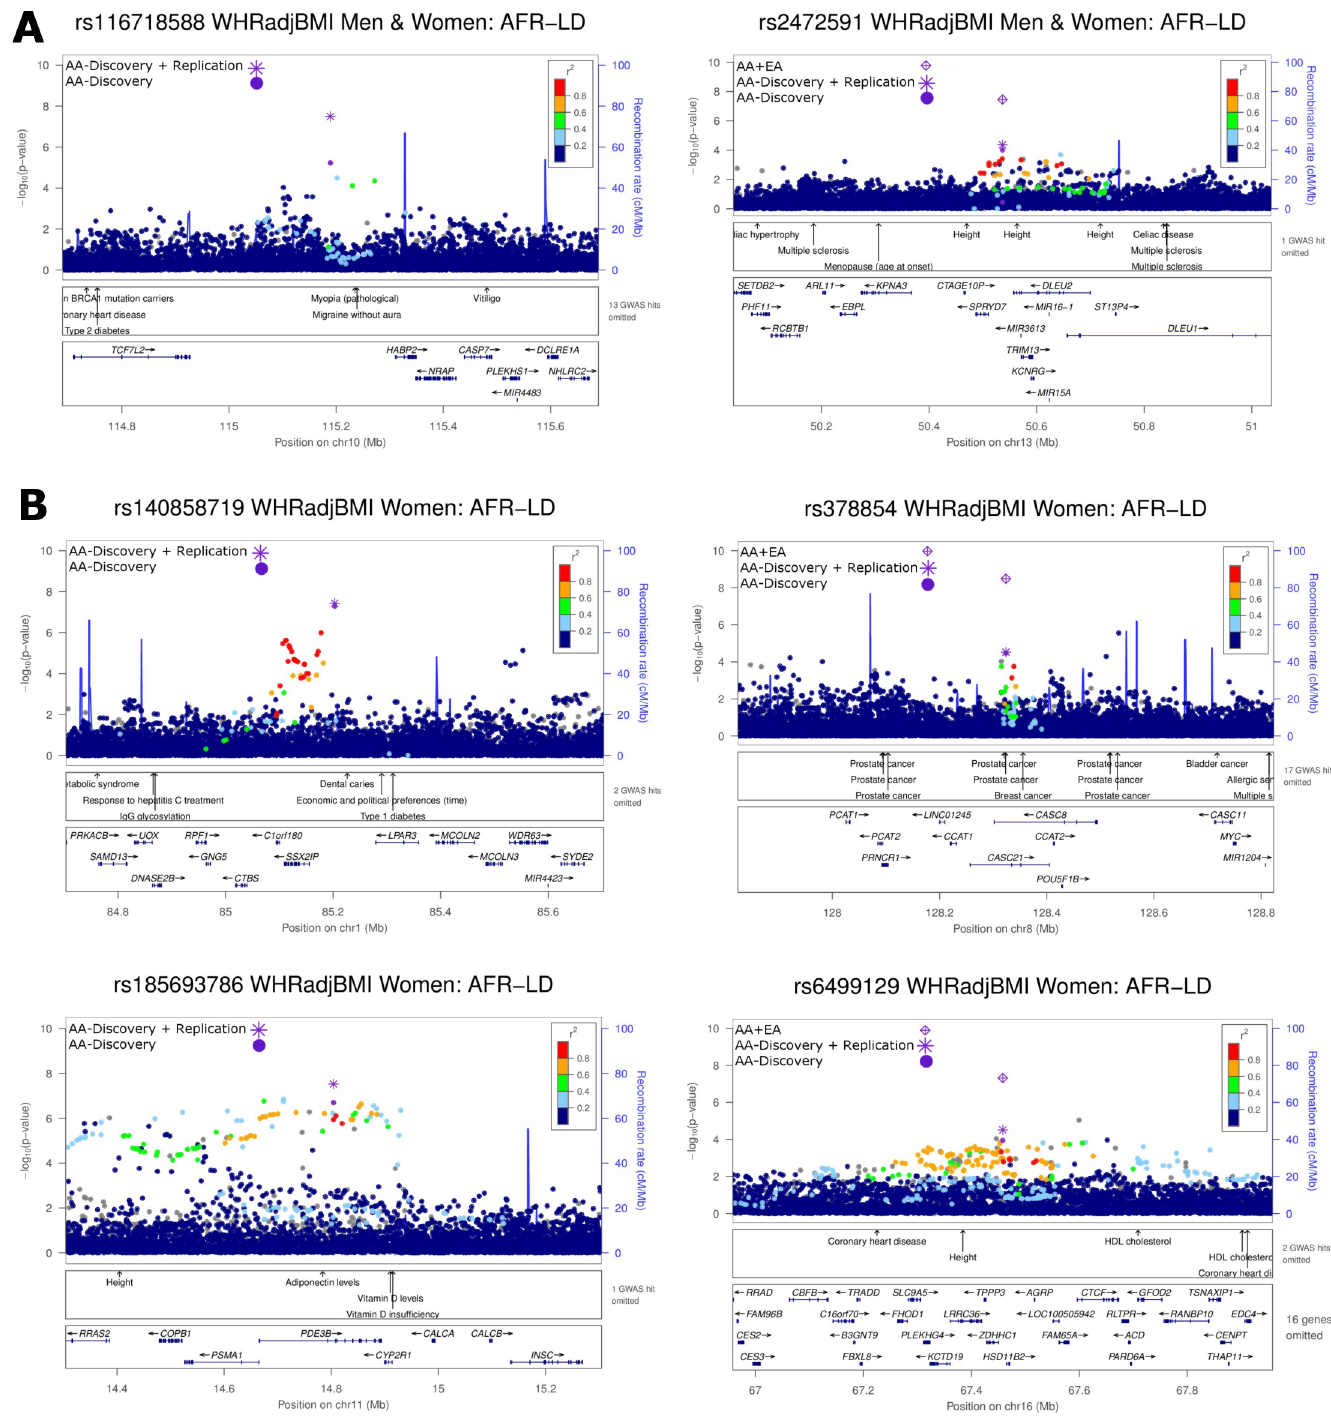
Fig 1. Locuszoom plots of six novel waist-to-hip ratio adjusted for BMI (WHR adjBMI ) loci: (A) TCF7L2/HABP2 and SPRYD7/DLEU2 in men and women combined;and (B) SSX2IP , PDE3B , CASC8 , and ZDHHC1/HSD11B2 in women only. All plots use AFR LD from the 1000 Genomes phase1 reference panel.In each plot, the most significantvariant within a 1Mb regionallocus is highlighted. P -valuesfor all variants includingthe most significantvariant are basedon the African ancestry discovery phase only (AA-Discovery). In addition, for the most significantvariant, P -valuesare annotatedand illustrated from the African ancestry discovery and replication phases (AA-Discovery+Replication). SNP rs2472591 was availablein the Europeansfrom the GIANT consortiumeffort and combinedwith the African ancestry discovery and replicationphases (AA+EA).